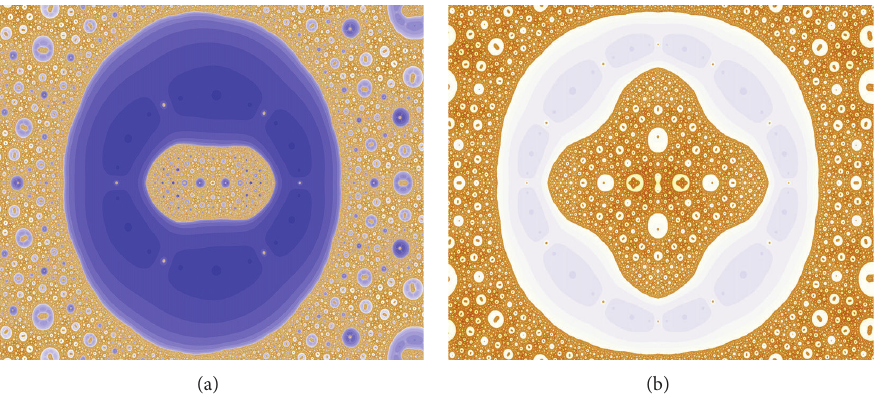
̃𝑅(𝑧,0.004355) with connectivities 8 and 14,